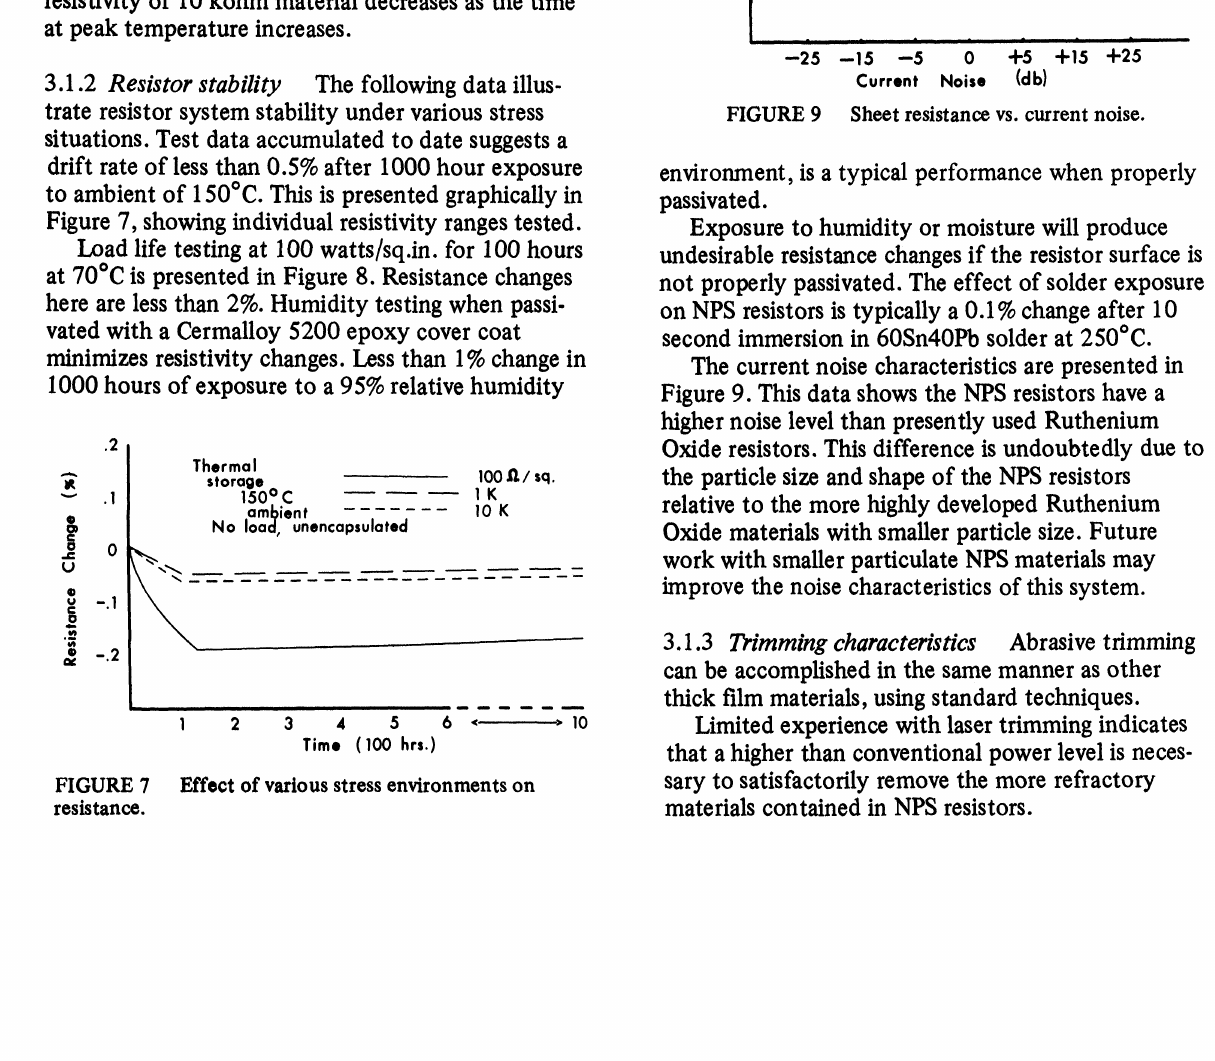
FIGURE 6 temperature.